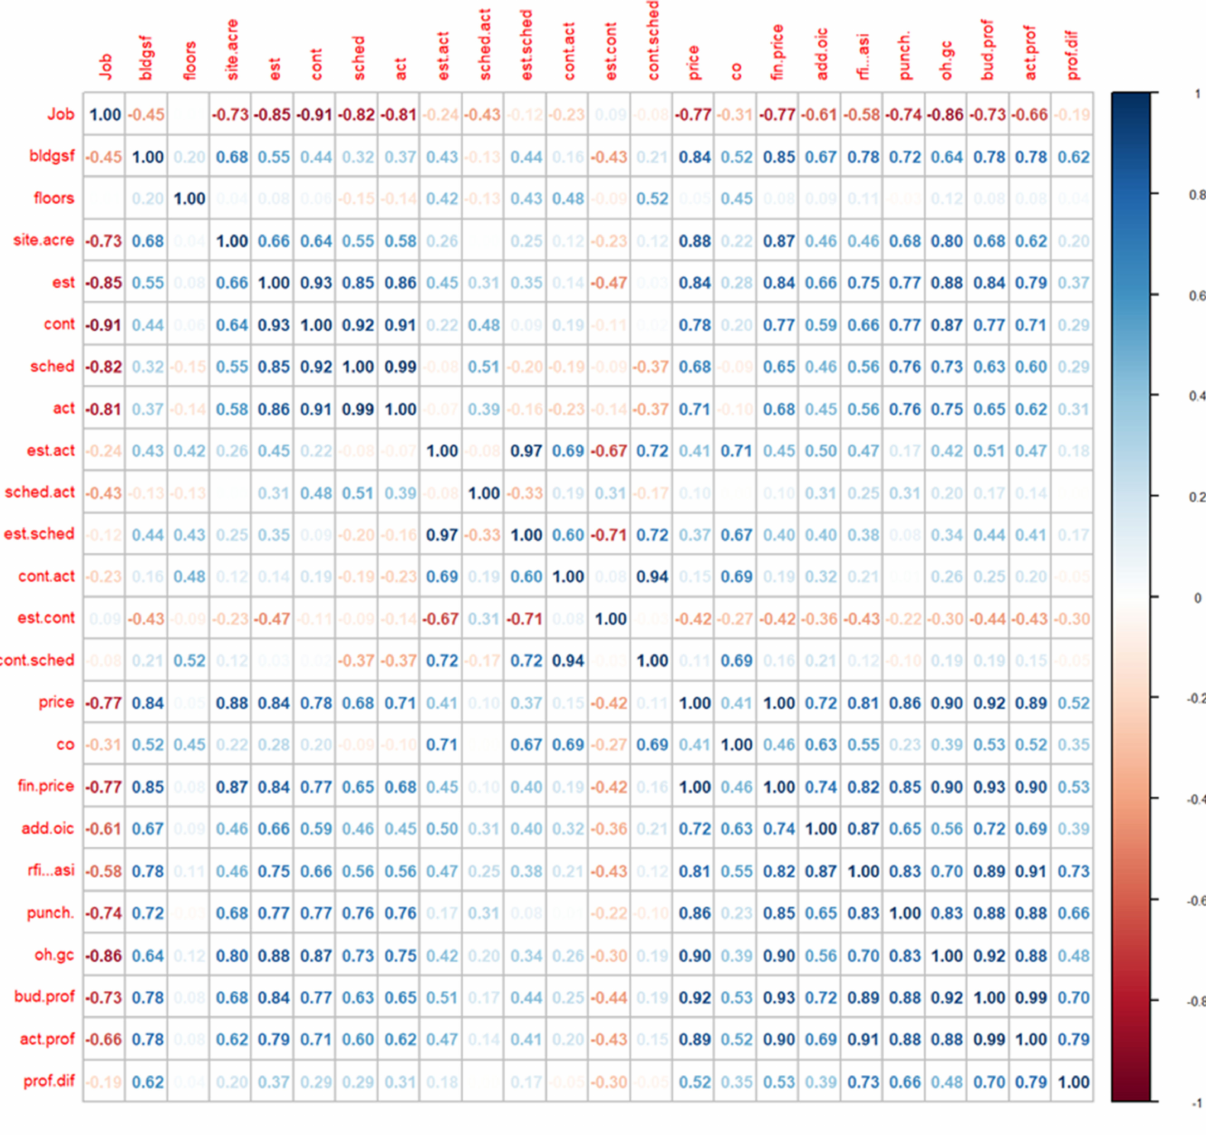
Figure 2. Correlation matrix of project data